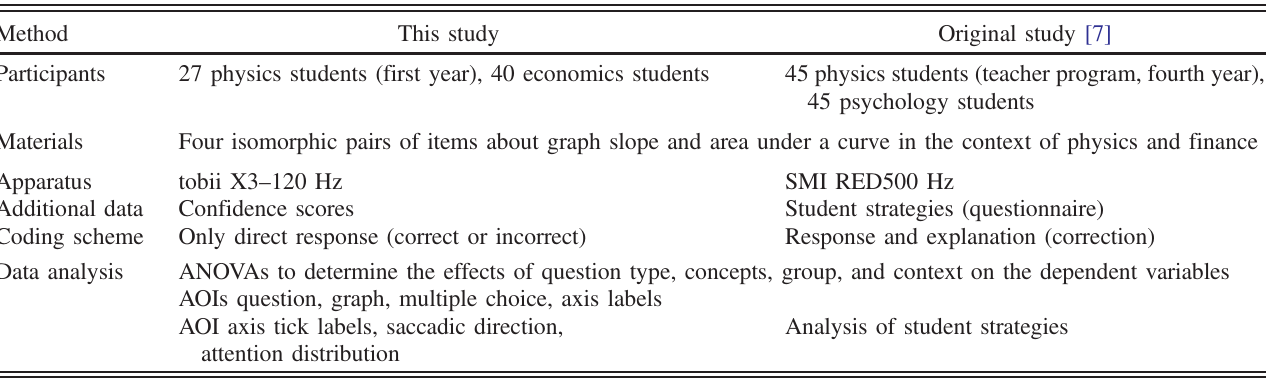
TABLE I. Comparison of methodological features between the study presented here and the original study from Susac et al. [7].